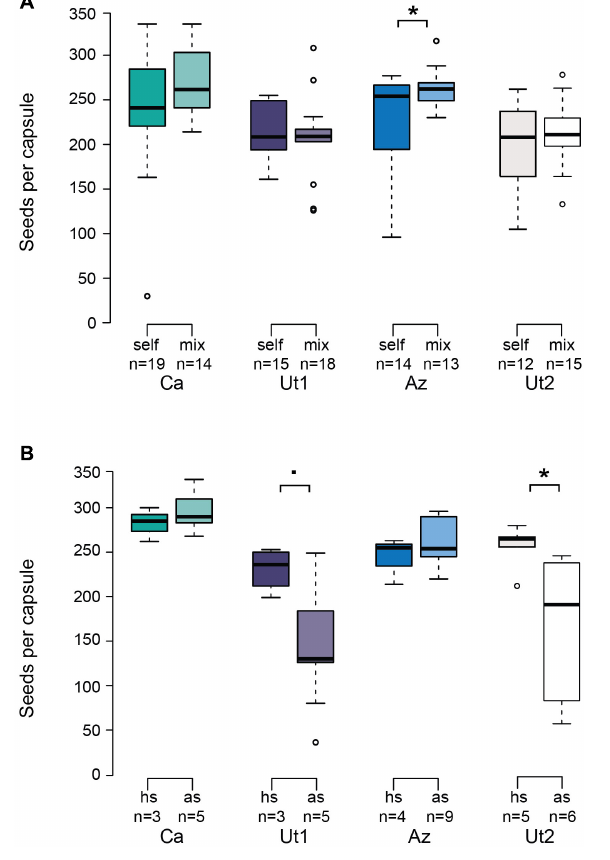
FIGURE 4 | Seed output after natural selfing and hand pollination with self and mixed pollen. (A) Seed output of emasculated flowers hand pollinated with self pollen (“self,” left box) or a pollen mixture of all four accessions (“mix,” right box). (B) Seed output of natural selfing flowers (autogamous selfing “as,” right bars) in comparison with nonemasculated flowers hand pollinated with additional self pollen (selfing hand “hs,” left bars). Whiskers of the boxplots indicate 1.5 times the interquartile range; boxes depict first and third quartiles; centerline indicates median. Statistics for both data sets were performed using a generalized linear model followed by a pairwise Wilcoxon test to compare between both treatments of the same accession. Numbers below the x -axis represent the number of replicates. Asterisks indicate statistically significant differences ( p < 0.05); dot indicates near statistically difference ( p <